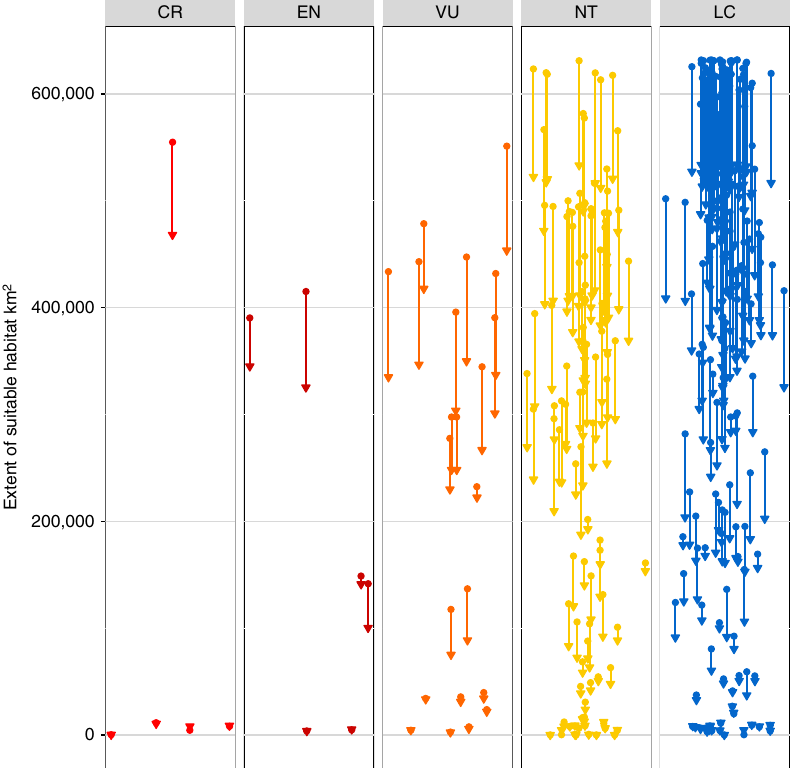
Fig. 1 Loss-of-habitat in forest-dependent Sundaland birds. Change in suitable habitat, not including the impact of exploitation, for each of the 308 studied species between 2000 and 2015, split by their current IUCN Red-list status: critically endangered (CR), endangered (EN), vulnerable (VU), near threatened (NT), and least concern (LC). The circles represent the extent of suitable habitat in 2000 and the triangles in 2015; the lines are drawn between the circle and triangle for the same species to highlight the species-speci fi c